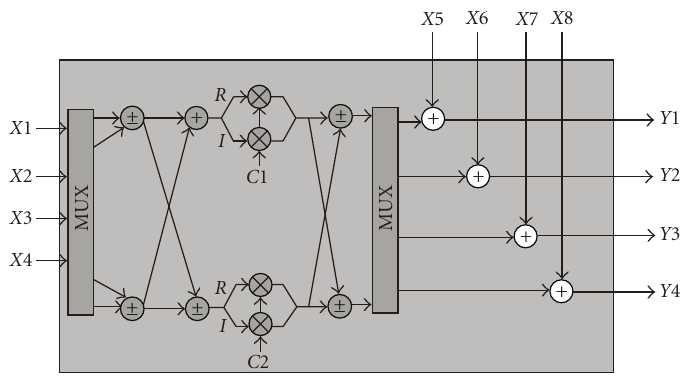
Figure 10: Block diagram of the AU architecture.